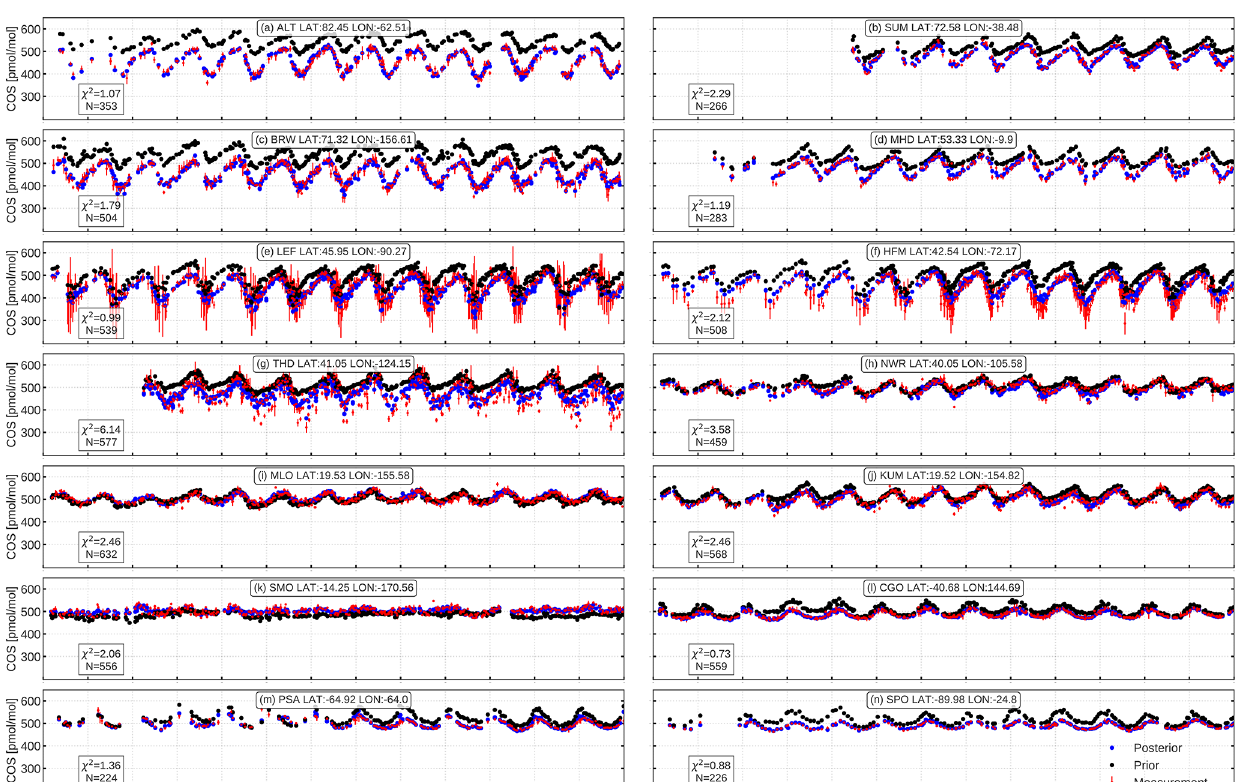
Figure 4. COS prior and posterior comparison at NOAA stations. Red dots and bars are NOAA measurements with errors. Blue and black dots represent the posterior and prior simulation, respectively. Results are shown for inversion S u in which only the unknown emission category is